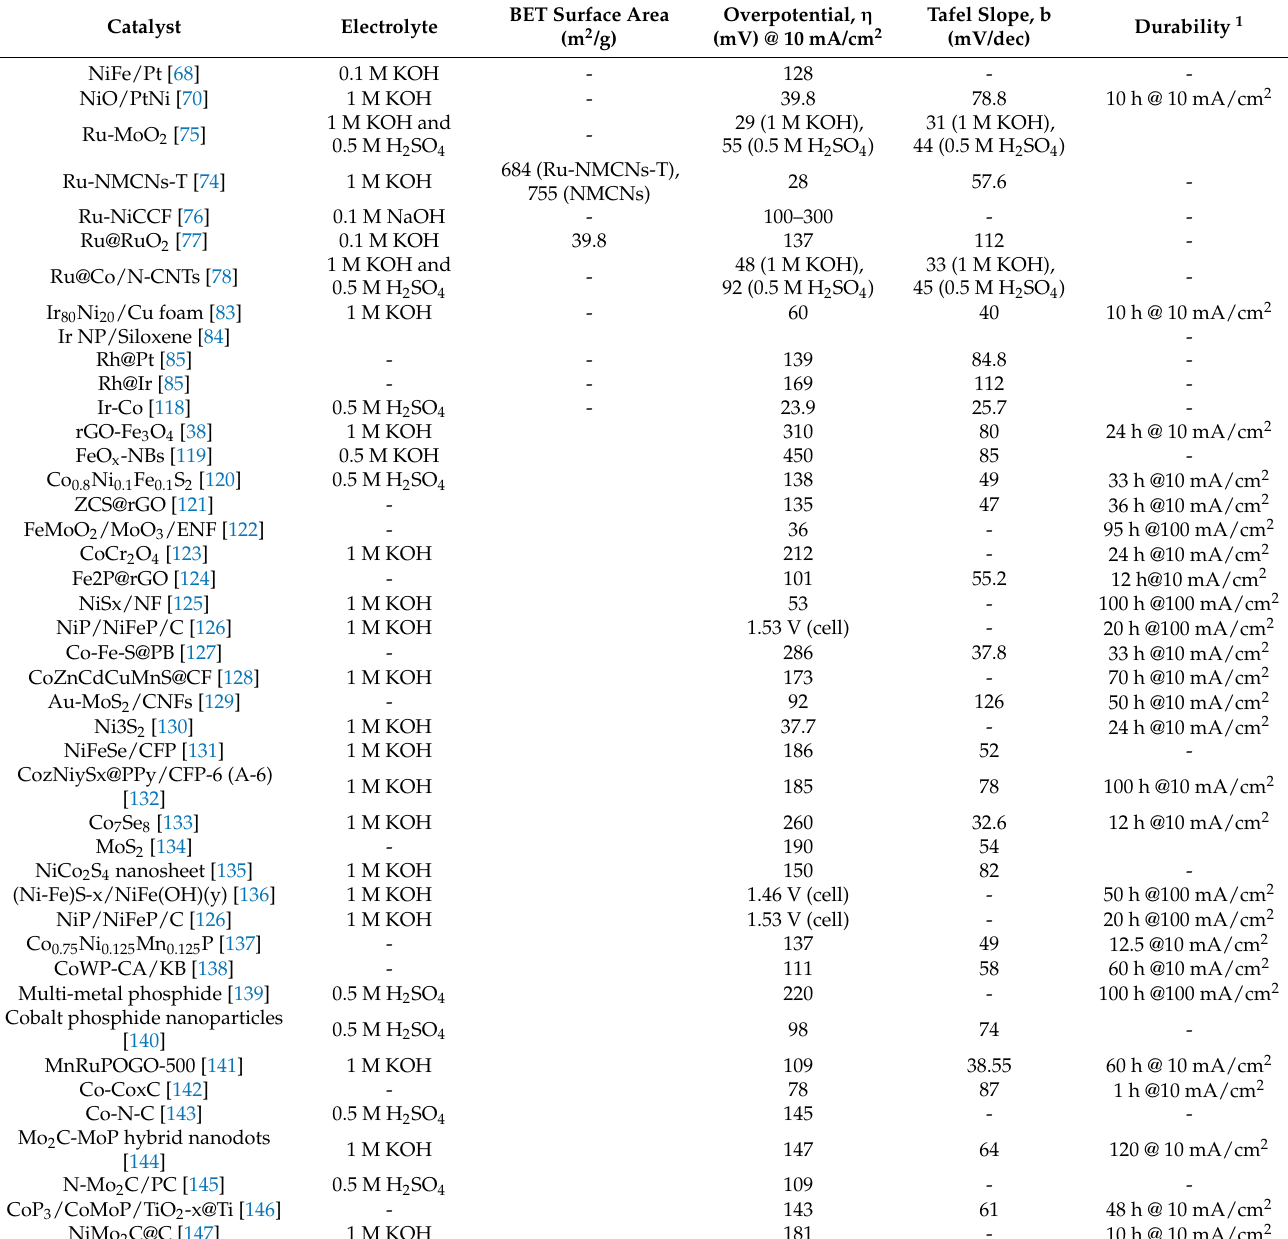
Table 1. Summary of hydrogen evolution reaction (HER) properties of transition-metal-based